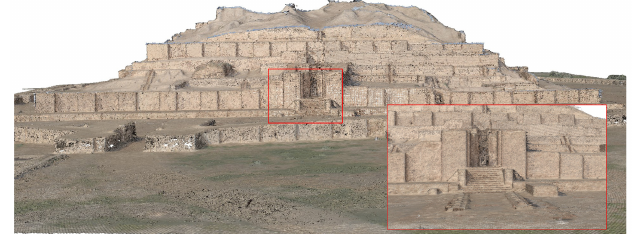
Figure 16. Facade view of the merged point